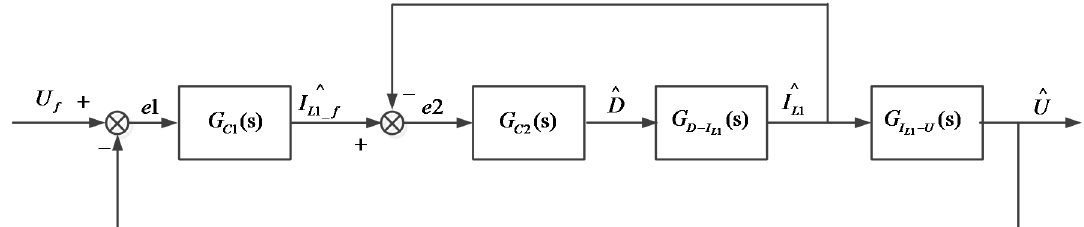
Figure 7. DC/DC converter voltage-current double closed-loop control system.